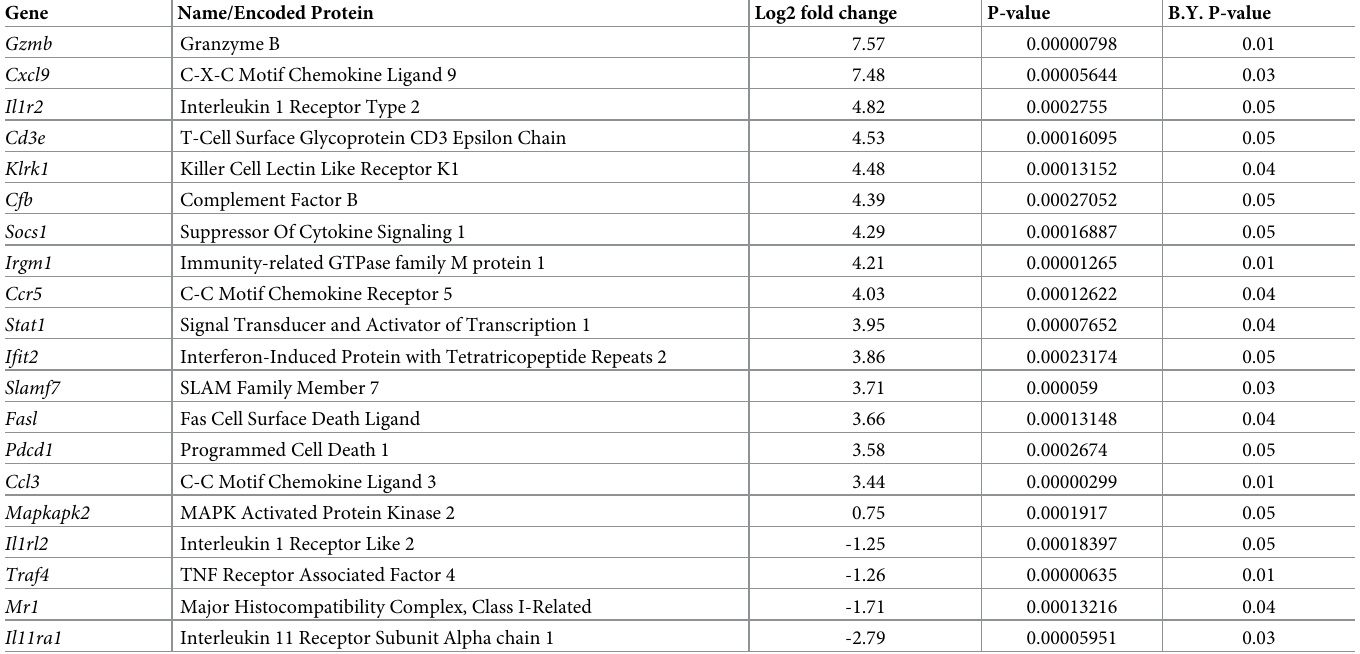
Table 1. Differentially expressed genes filtered by adjusted test statistic (D8 vs. Mock).